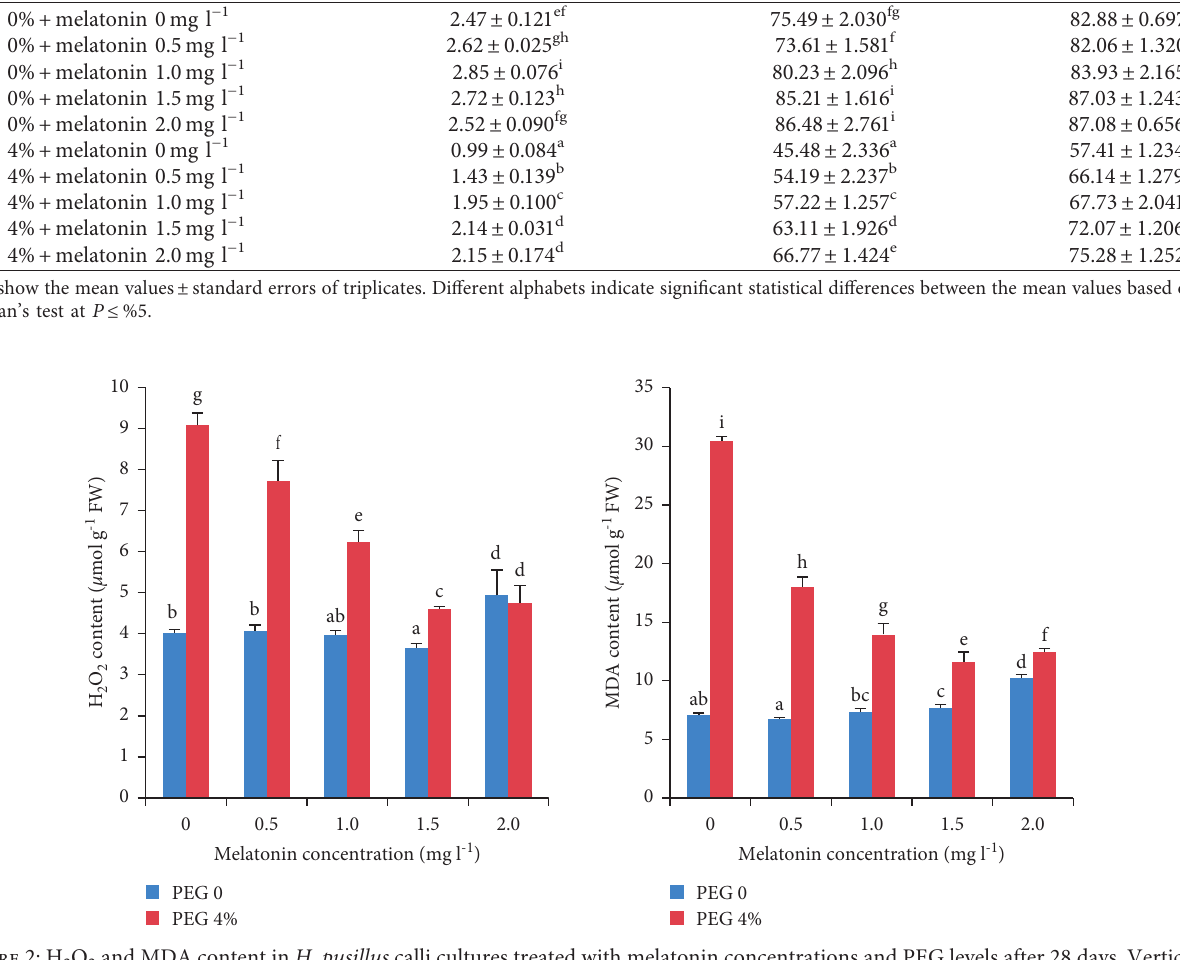
Table 2: Total chlorophyll (Chl T), membrane stability index (MSI), and relative water content (RWC) in H. pusillus calli cultures treated with melatonin and PEG levels after 28 days. Treatments